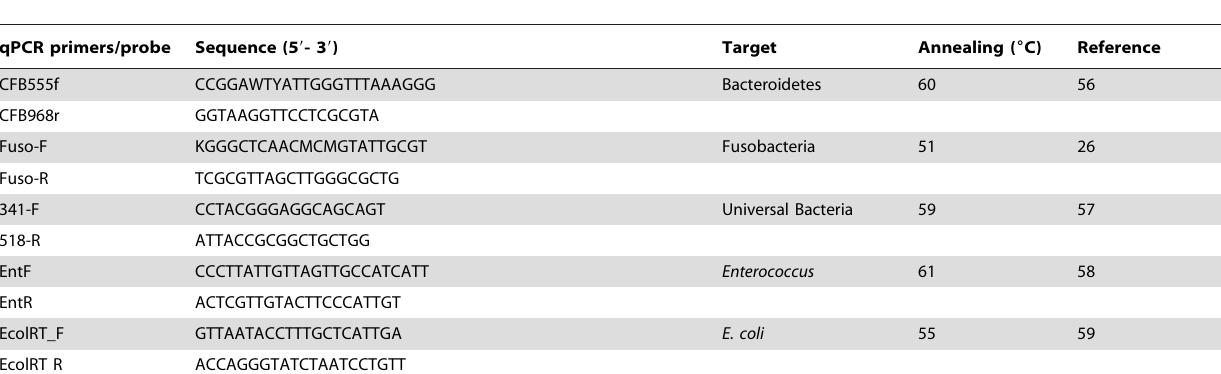
Table 1. Oligonucleotide primers/probes used for this